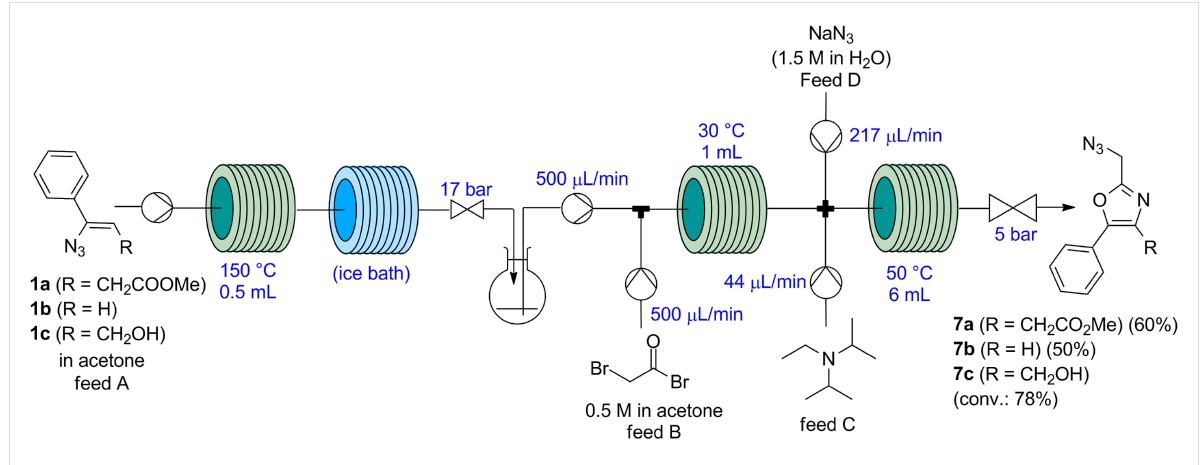
oxazoles 6a and 6b were obtained in full conversion, with 81% and 59% purity (HPLC). Unfortunately, the oxazoles could not be precipitated as hydrobromide salts even after cooling at − 20 °C and adding petroleum ether as co-solvent. The work-up consisted in extraction with aqueous NaHCO 3 , evaporation of the organic phase, and purification of the residue by column chromatography. Relatively poor isolated yields (42% and 35% for compounds 6a and 6b , respectively) were achieved due to decomposition of the products during isolation. The decomposi- tion of the 2-(bromomethyl)oxazoles inside the column was apparent, both when silica or neutral alumina were used as sta- tionary phase.